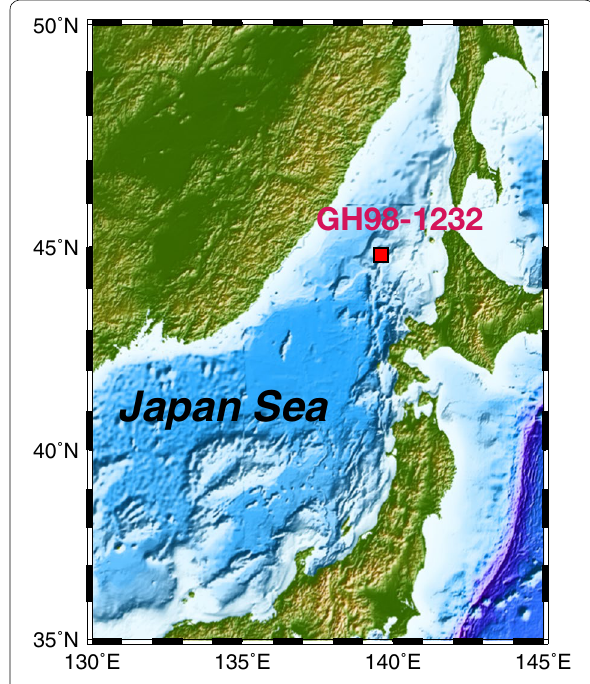
Fig. 1 Location of the studied core in the Japan Sea